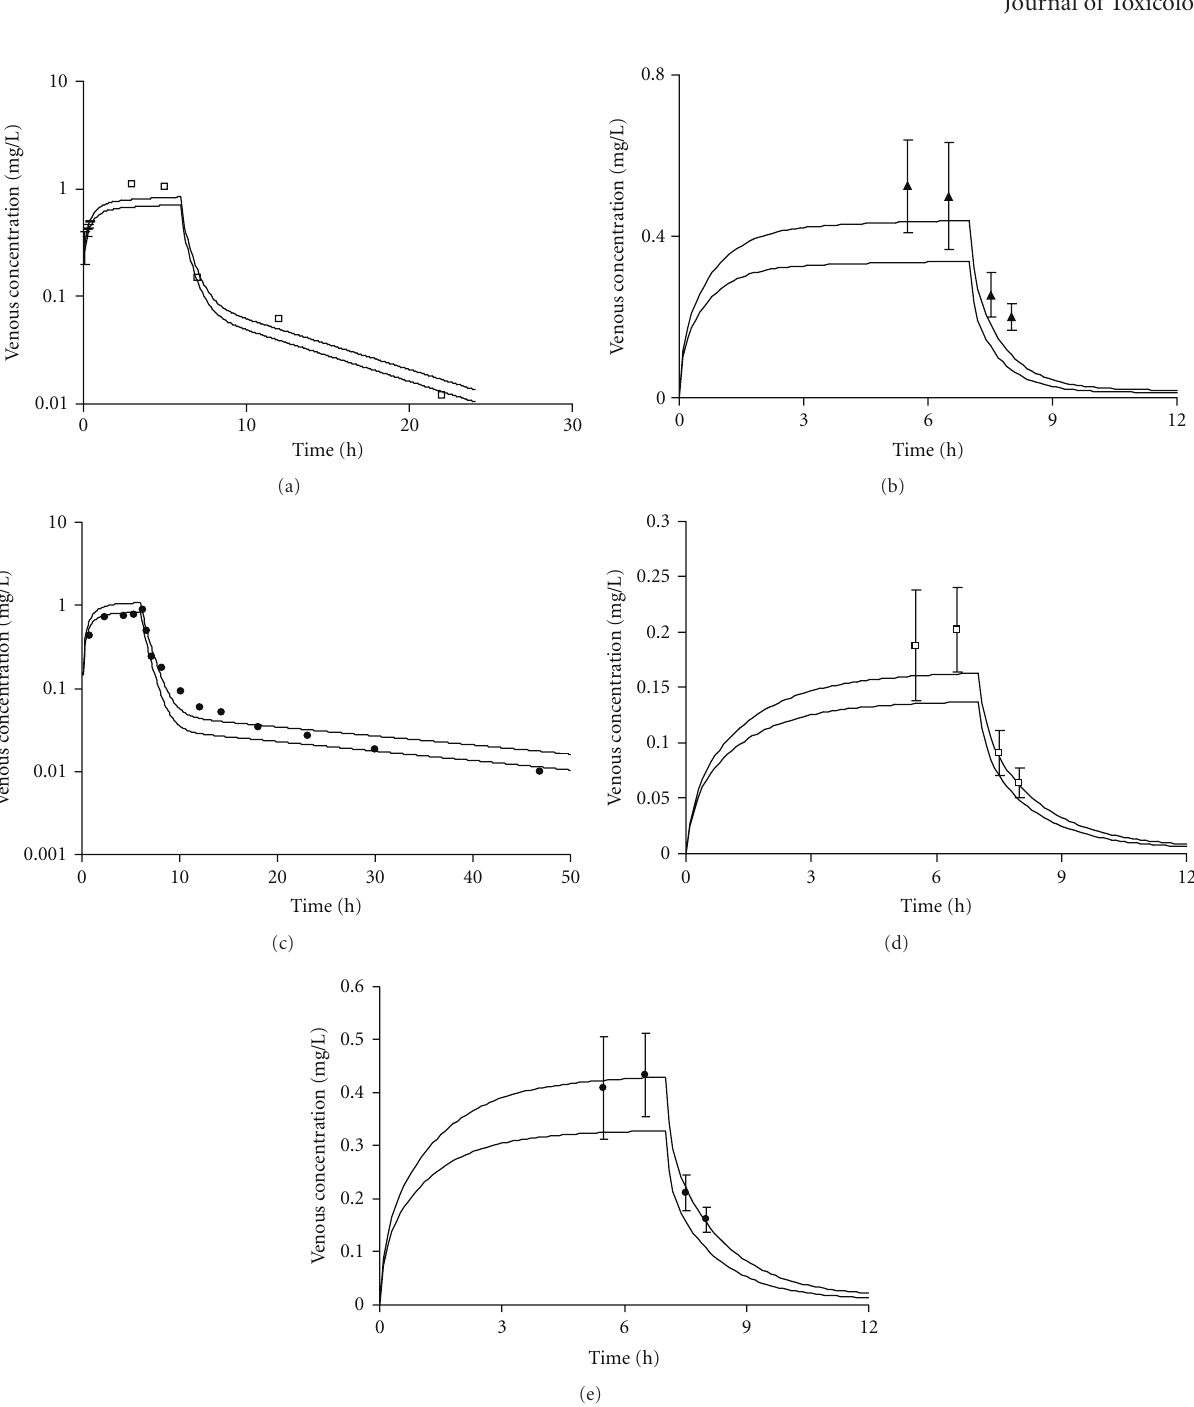
1,1,1,2-tetrachloroethane; 1,1,2,2-tetrachloroethane; tolu- ene; 1,1,2-trichloroethane; trichloroethylene; m -xylene) the prediction uncertainty was low, thus the confidence in using the QPPR in the PBPK model is high for these